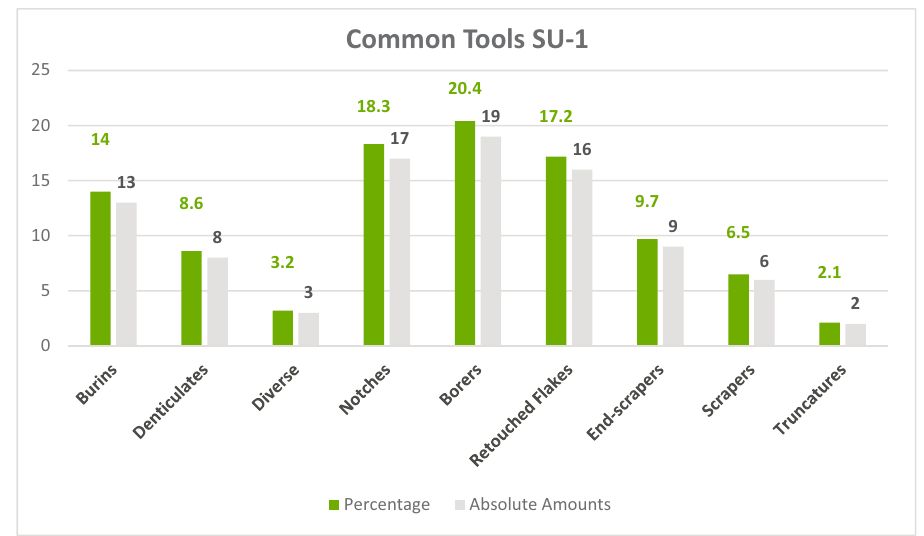
Figure 6: Common tools SU - 1 ( percentage and absolute amounts )